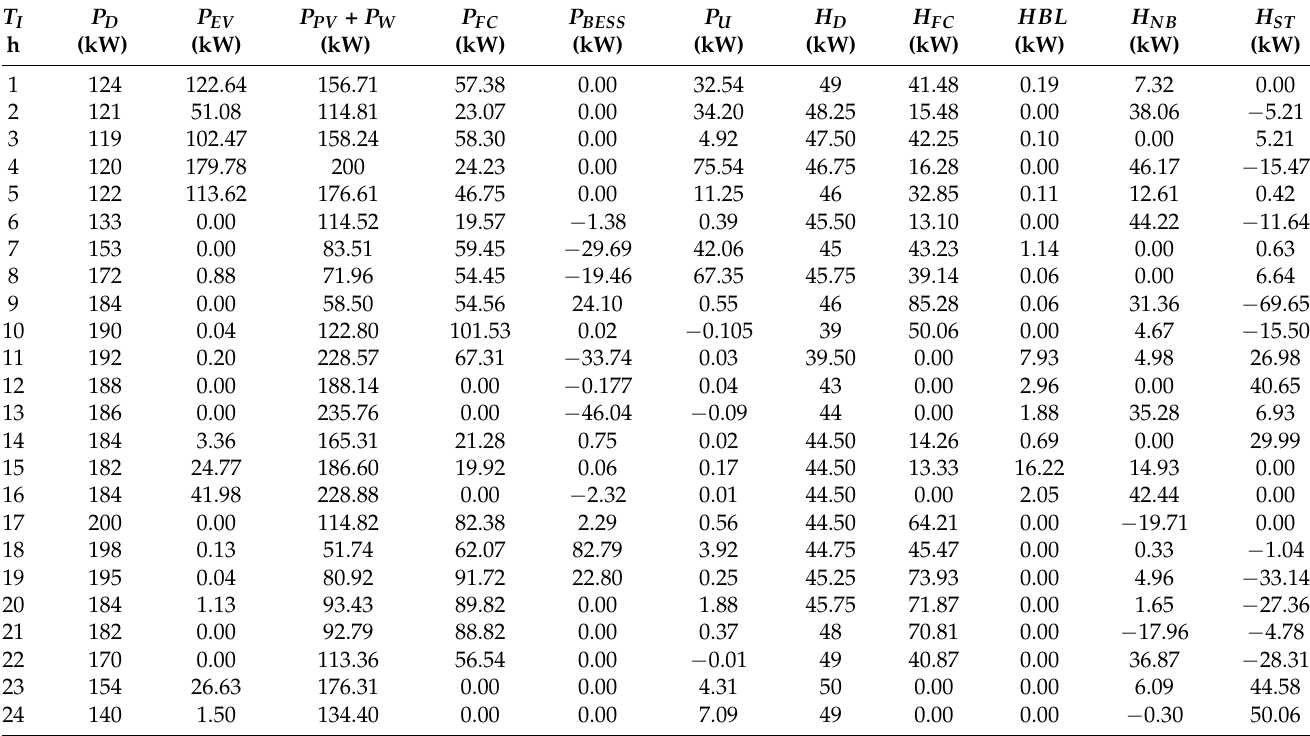
Table 6. 24 h power demands and